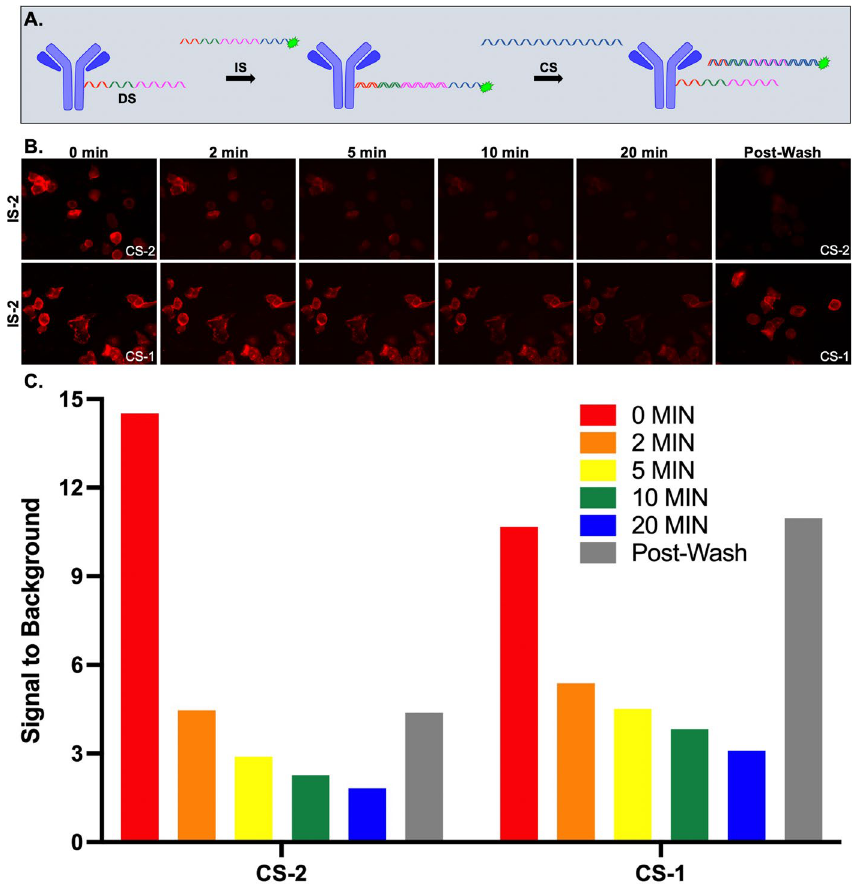
Figure 3. Strand-mediated displacement signal removal. ( A ) The docking strand (DS) sequence was antibody conjugated and labeled in situ through hybridization of the complementary imaging strand conjugated to a fluorophore. The IS contained 16 nt complementarity to the DS while also having a 6 nt toe-hold region not complementary to the DS sequence. The capture strand (CS) had full 22 nt complementarity to the IS and could be incubated with the DS/IS stained sample facilitating complete IS/CS hybridization for fluorescence signal removal. ( B ) SK-BR-3 cells stained with DS-2-HER2 Ab-oligo conjugate were detected via fluorophore labeled IS-2. Stained cells were then incubated either with the complementary CS-2 or the non-complementary CS-1. Images were collected after 0, 2, 5, 10 and 20 min of incubation with either CS-2 or CS-1 in the same field of view (FOV). Images in a different FOV were collected after 20 min of CS incubation and washing of the sample. C. Signal to background ratios following incubation with the complementary and non-complementary CS were